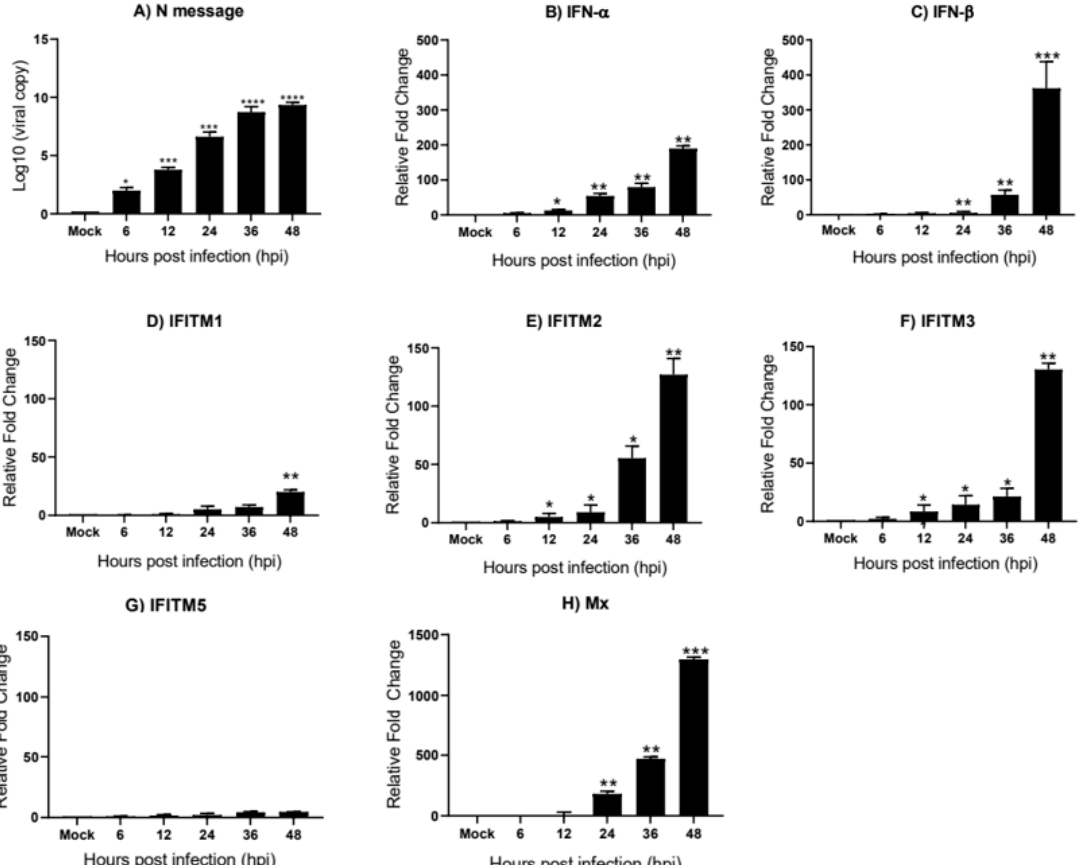
Figure 5. chIFITM1 , 2 , 3 and IFNs are significantly induced in DF-1 cells after Beau-R infection DF-1 cells were infected with MOI of 1 of Beau-R and harvested at 6, 12, 24, 36 and 48 hpi, respectively. ( A ) Replicating virus detected by qRT-PCR using primers and a probe specific for the N message of Beau-R. qRT-PCR was performed to determine the relative mRNA expression of ( B ) IFN- α , ( C ) IFN- β , ( D – G ) chIFITM1 , 2 , 3 , and 5 and ( H ) Mx compared to mock-infected cells. Relative fold change was calculated using the ∆∆ CT equation, relative to mock and normalized to two reference genes, RPL13 and RPLPO . Error bars show standard deviations of the means (n = 3). * indicates p < 0.05; ** indicates p < 0.01; *** indicates p < 0.001; **** indicates p < 0.0001. ANOVA data were corrected for multiple comparisons using the Bonferroni adjustment method (GraphPad).